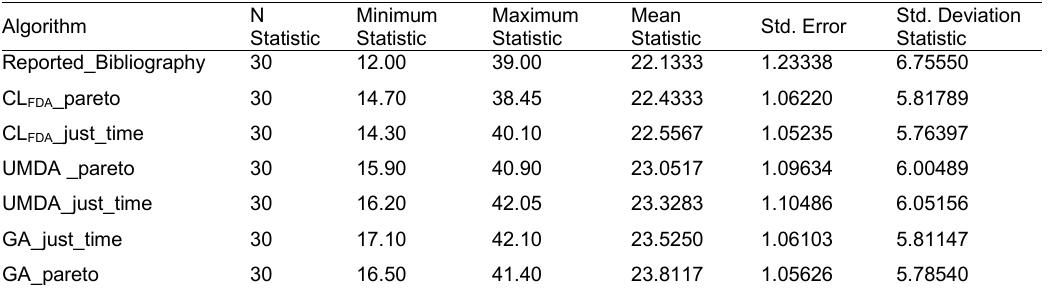
Table 9. Descriptive analysis, variable Mean_Makespan (c15_9, c15_10 and c15_12 datasets)